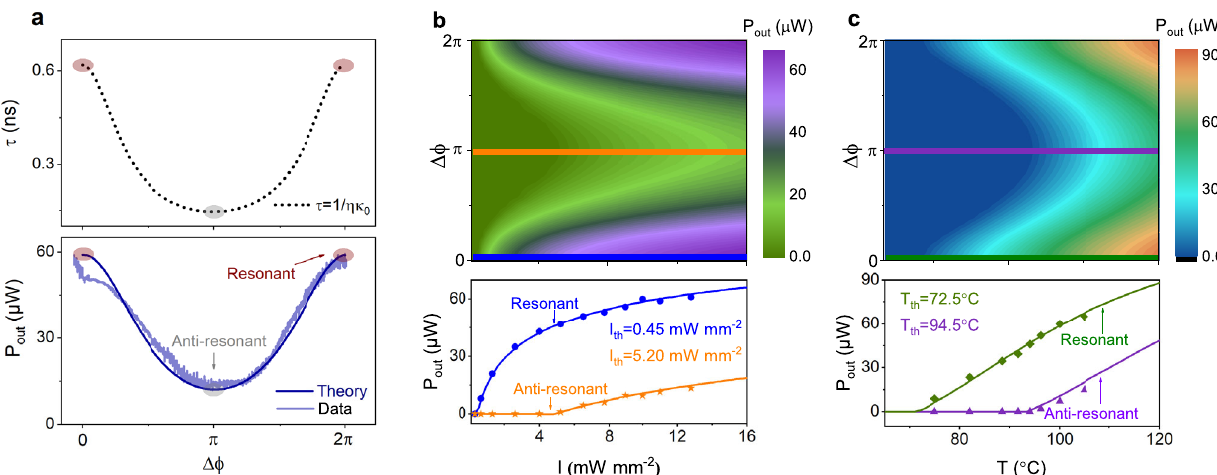
Fig. 2 Intracavity photon lifetime and primary laser power behavior. a Intracavity photon lifetime τ (black dots) is inversely proportional to the loss coef fi cient η described by Eq. (3). The experimental (light-blue line) and simulated (dark-blue line) results of the output laser power P out match well under the condition of g = 1.99 × 10 5 s − 1 , Ω = 4.30 × 10 7 s − 1 , and N eff = 5.71 × 10 9 . b Output laser power P out as a function of the phase shift Δ ϕ at different pumping light intensities I under vapor-cell temperature T = 100 ∘ C. The blue and orange lines represent P out vs. the pumping light intensity when the cavity is on-resonant and anti-resonant, respectively. The blue circles and the orange stars are the corresponding experimental results. The pumping light intensities reaching the laser threshold were around 0.45 and 5.20 mWmm − 2 when the cavity was resonant and anti-resonant, respectively. c P out as a function of Δ ϕ at different vapor-cell temperatures T under I = 10 mWmm − 2 . Theoretical and experimental P out vs. T when the cavity is resonant (green) and anti-resonant (purple) are separately depicted by the lines and dots, respectively. The corresponding temperatures for the laser threshold were 72.5 ∘ C and 94.5 ∘ C, respectively. The experimental data in Fig. 2b, c is obtained by single measurement. The deviation between experiment and theory is caused by the detection sensitivity error of the